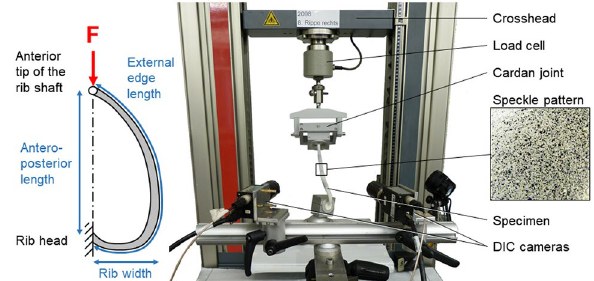
Figure 4. Illustration of the test setup.